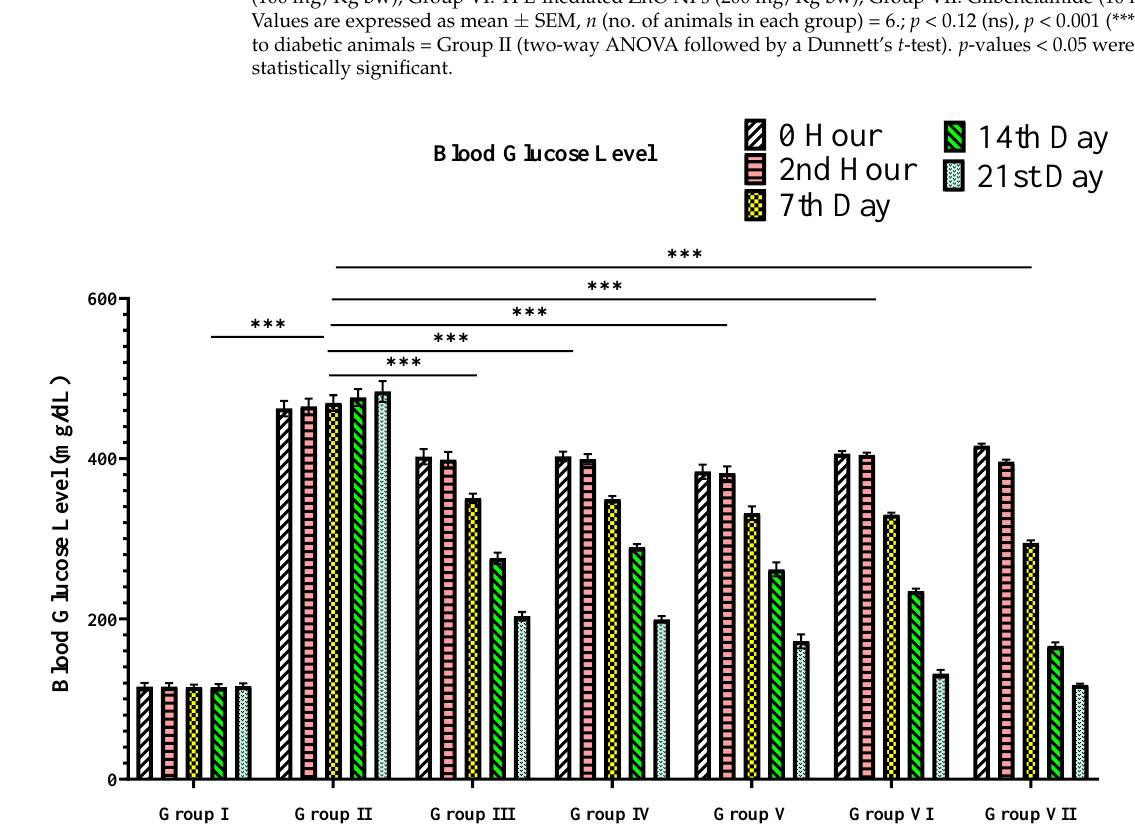
Figure 6. Graphical representation of the effects of TPE and TPE-ZnO NPs on glycemia (mg/dL) in STZ-induced diabetic rats. Group I: Normal control (0.1% CMC suspension); Group II: Diabetic control (received STZ 55 mg/Kg bw); Group III: TPE (100 mg/Kg bw); Group IV: TPE (200 mg/Kg bw) treatment; Group V: TPE-mediated ZnO NPs (100 mg/Kg bw); Group VI: TPE-mediated ZnO NPs (200 mg/Kg bw); Group VII: Glibenclamide (10 mg/Kg bw). Values are expressed as mean ± SEM, n (no. of animals in each group) = 6.; p < 0.001 (***) compared to diabetic animals = Group II (two-way ANOVA followed by a Dunnett ’ s t -test). p -values < 0.05 were considered statistically sig- nificant. 3.2.2. Body Weight As shown in Table 4 and Figure 7, the bw has been reduced progressively from the 1st to 21st day in diabetic rats. However, bw loss was prevented after treating diabetic rats with glibenclamide, TPE, and TPE-ZnO NPs. The bw was prominently regained in the TPE-ZnO NPs compared to TPE alone. Table 4. Graphical representation of TPE and TPE-ZnO NPs ’ effects on body weight (g) in STZ- induced diabetic rats. Group